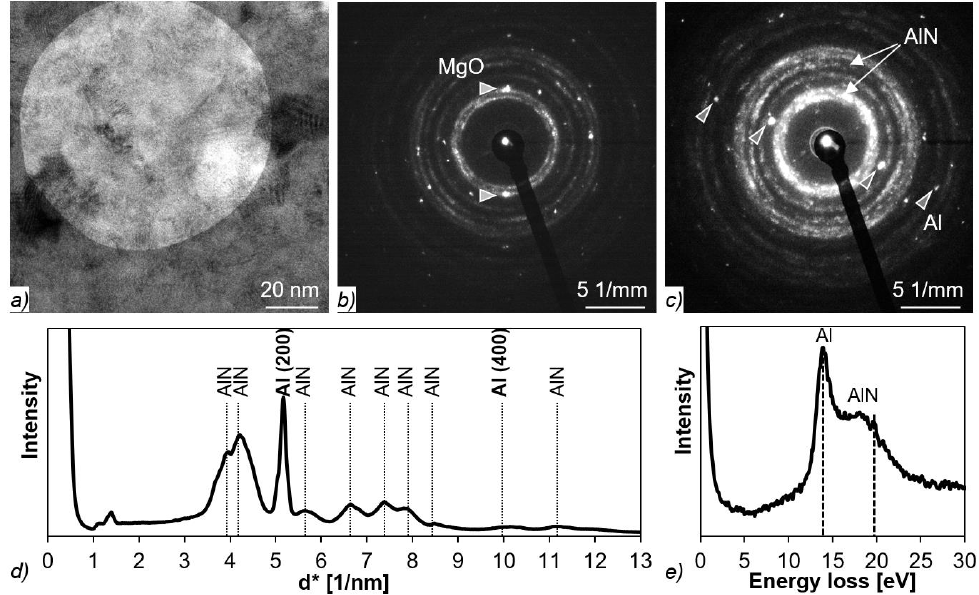
Figure 5. Phase analysis in the upper part of the AlN layer: ( a ) TEM image (bf) with area of SAED analysis and associated diffraction patterns of ( b ) AlN, and ( c ) Al; ( d ) radial intensity distribution of the diffraction pattern from ( b ) – ( c )); ( e ) energy loss spectrum.